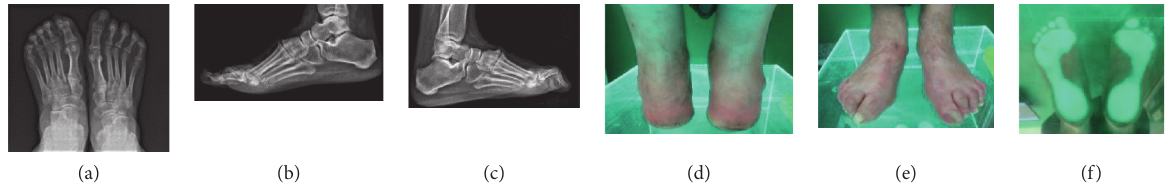
Figure 3: (a–f) Results of imaging tests (X-ray) and podoscopic tests: patient no. 4. (a) Dorsal-plantar foot X-ray: phalangeal valgity, degeneration of the interphalangeal joints, and additional navicular bone in the left foot. (b) Lateral X-ray: coronoid talus bone and degradation lesions in the phalangeal joints. (c) Lateral X-ray: coronoid talus bone and degradation lesions in the phalangeal joints. (d) Posterior picture: ankle joint and hindfoot evaluation. (e) Anterior picture of the feet: assessment of toe positioning and deformation. (f) Plantar photo on the podoscope: assessment of plantar part of the foot and height measurement of the longitudinal arch.